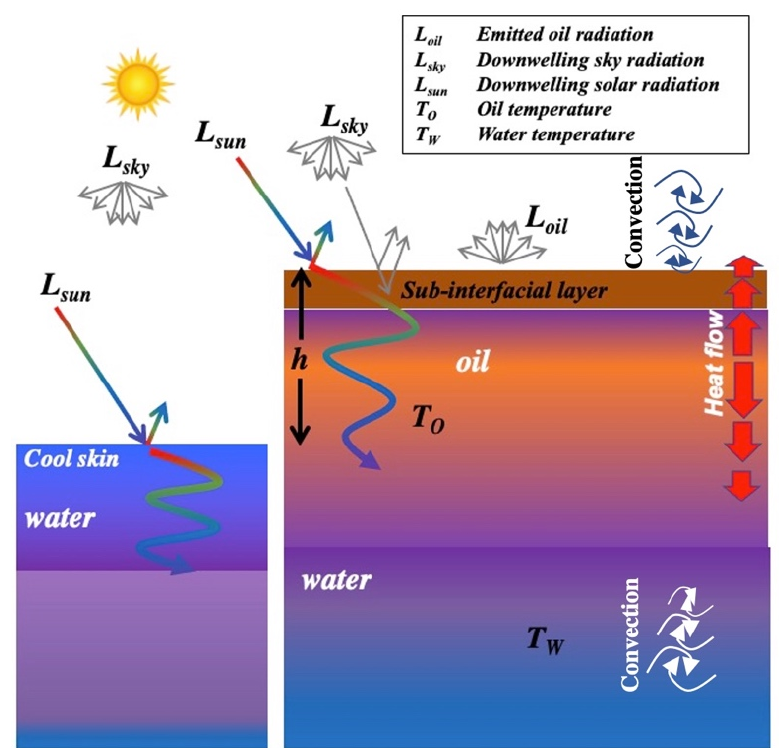
Figure 1. Oil slick thermal energy balance schematic illustrating the relationship between thickness, h , and oil-water thermal contrast.